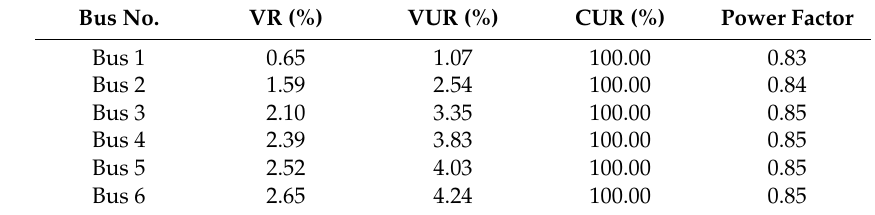
Figure 8. Power flow of Case 1. Table 2. Test result of Case 1.